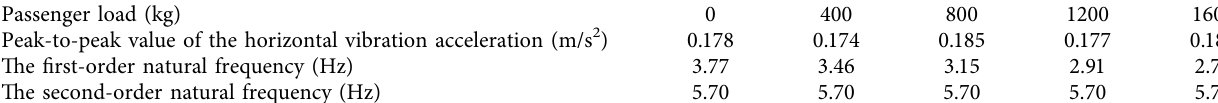
Table 4: Influence of the passenger load on horizontal vibration after vibration reduction optimization.